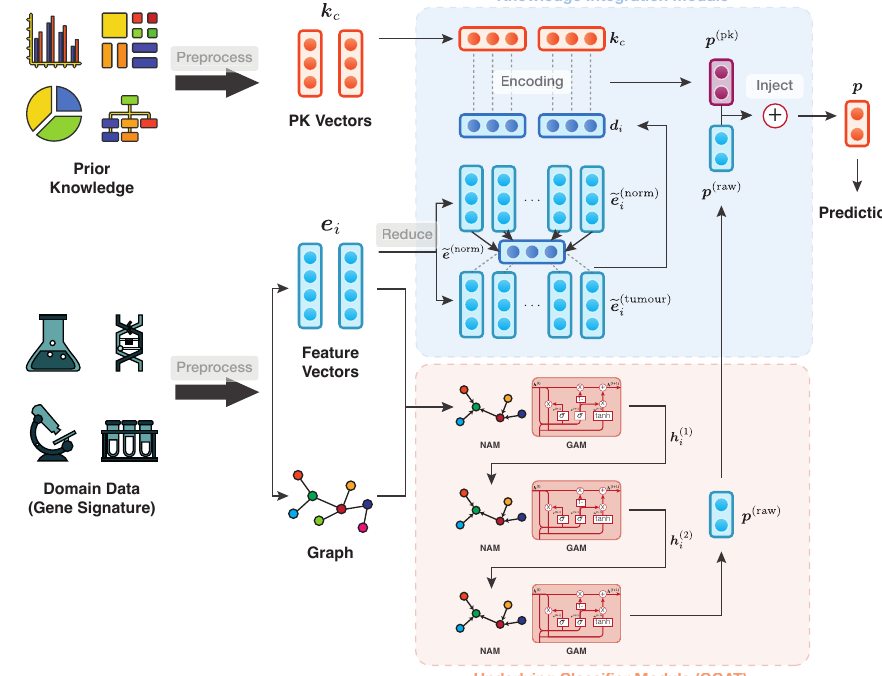
Figure 2. Data flow of